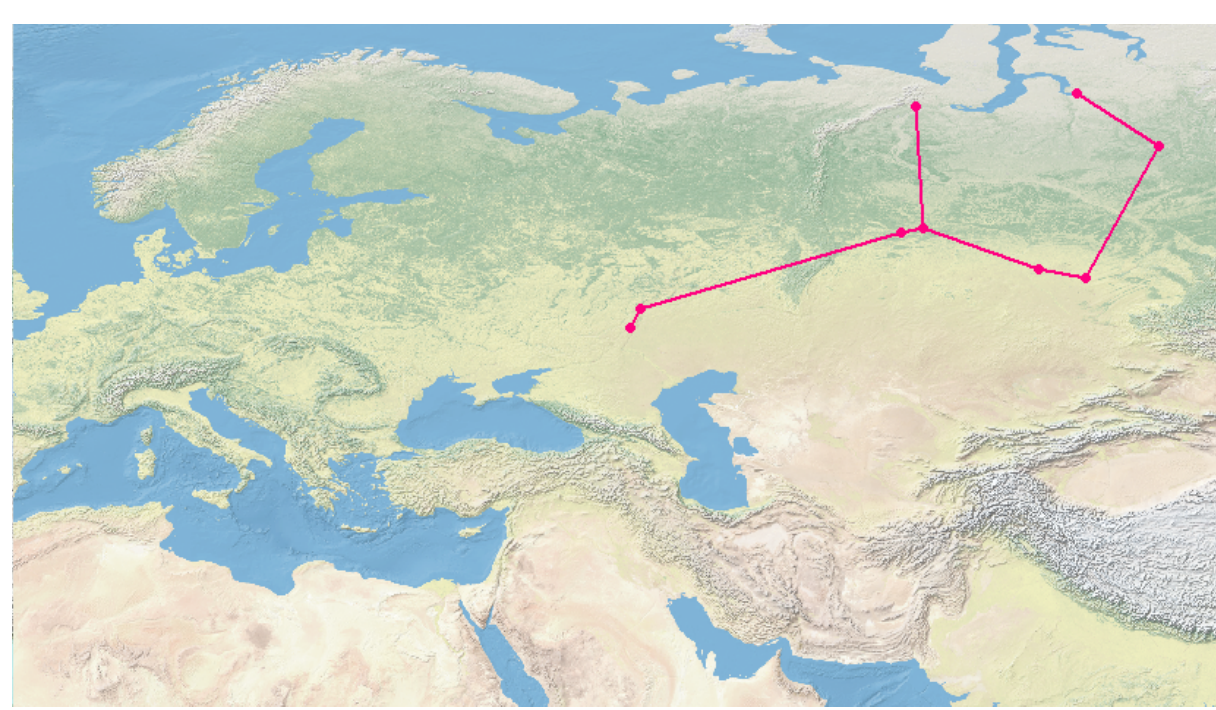
Figure 8. Individual track of Diaptomus mirus.